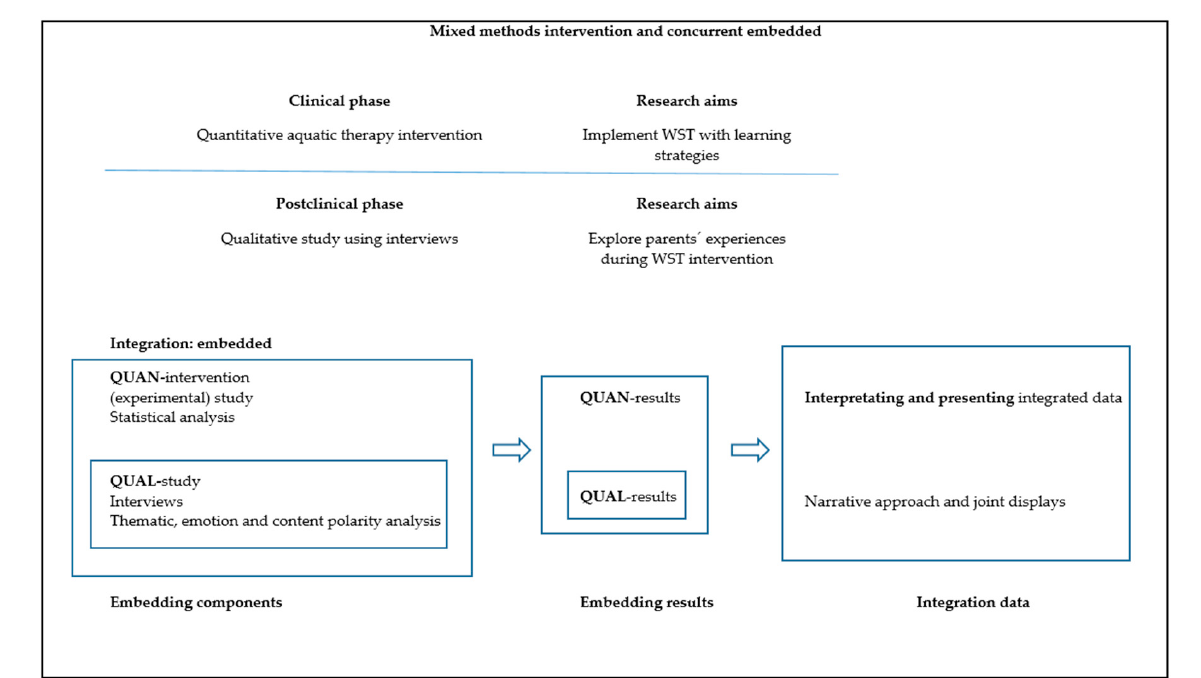
Figure 1. Mixed methods design and embedded integration. Quan, quantitative; Qual, qualitative; WST, Water Specific